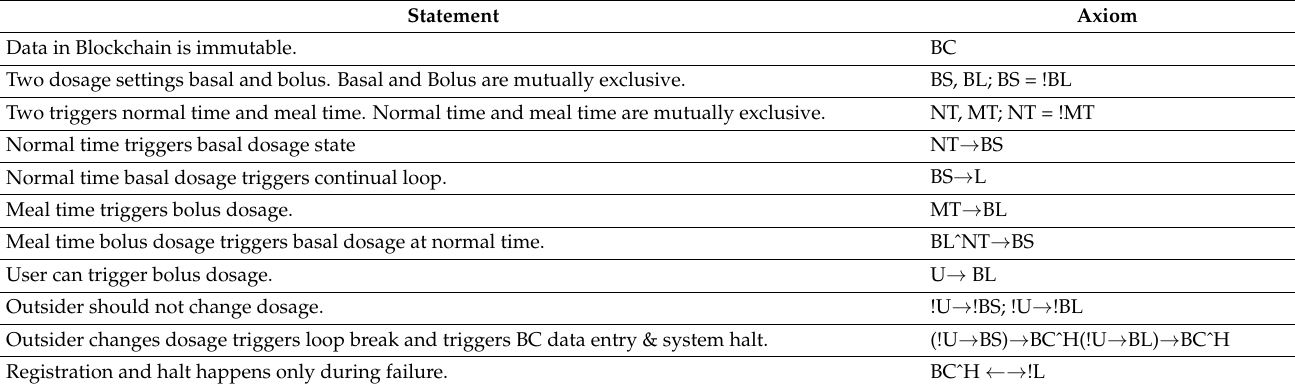
Table 4. Premises considered for the Blockchain-IoT